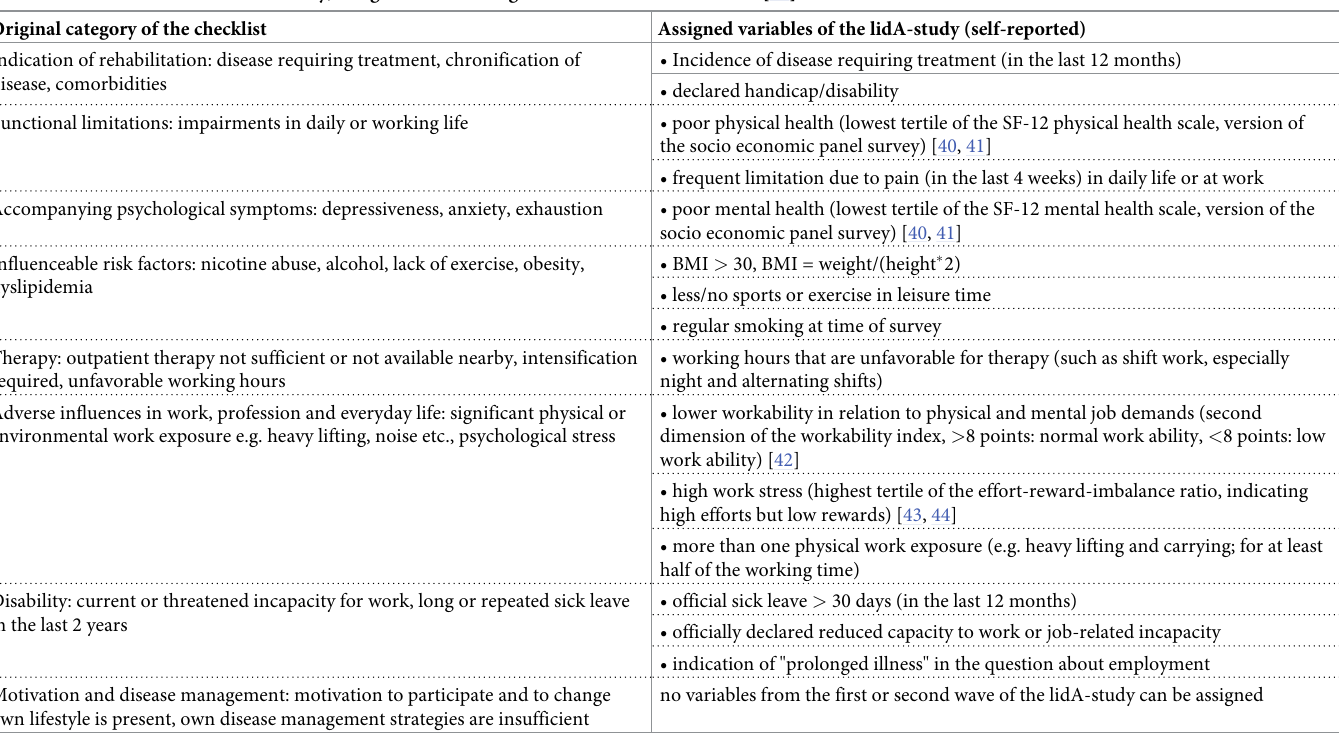
Table 1. Variables used in the lidA study, categorized according to the checklist of Deck et al. [16]. Original category of the